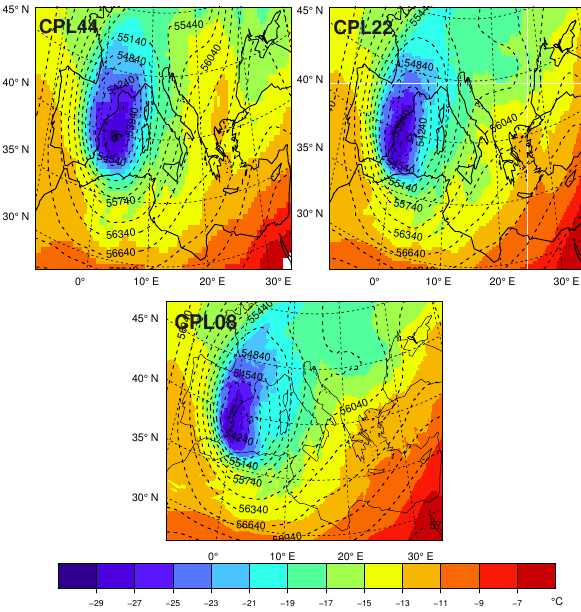
Figure 1. ME08; geopotential height (m 2 s − 2 ; dotted contours lines at 300m 2 s − 2 intervals) and temperature ( ◦ C; colored contours at 2 ◦ C intervals) at 500hPa in the coupled (0.44, 0.22, and 0 . 08 ◦ ) simulations on 6 October 1996 at 03:00UTC.